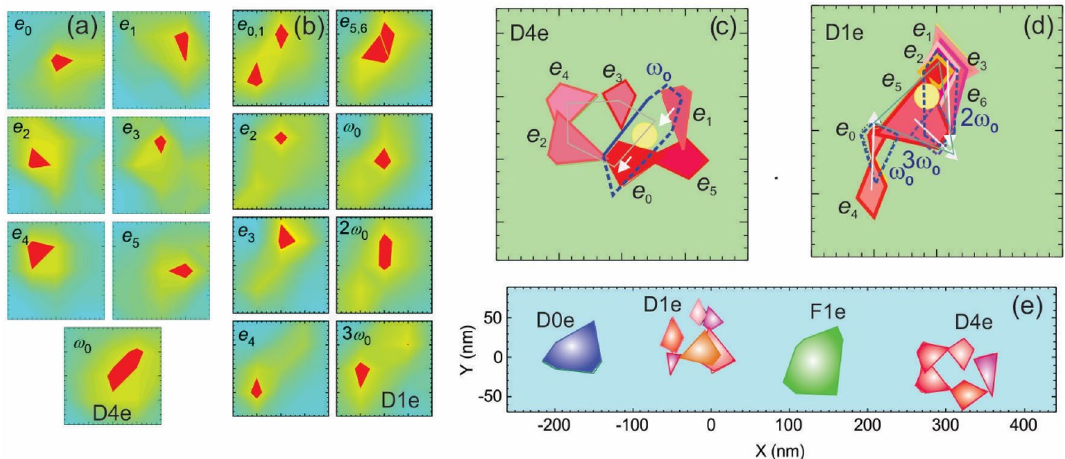
Figure 2. NSOM intensity images (size 200 × 200 nm 2 ) of the individual spectral lines of D4e (a) and D1e (b) QDs, respectively. Combined EAs of a and b, respectively ( c, d ). Solid shapes and dashed contours are ASCs and SCs, respectively. Arrows show the shift of the ASC EAs in the IS and a circle marks the expected location of a photo-excited hole. Dark–light color code of ASCs outlines line intensity. Combined maps of D0e, D1e, F1e and D4e in IS ( e)